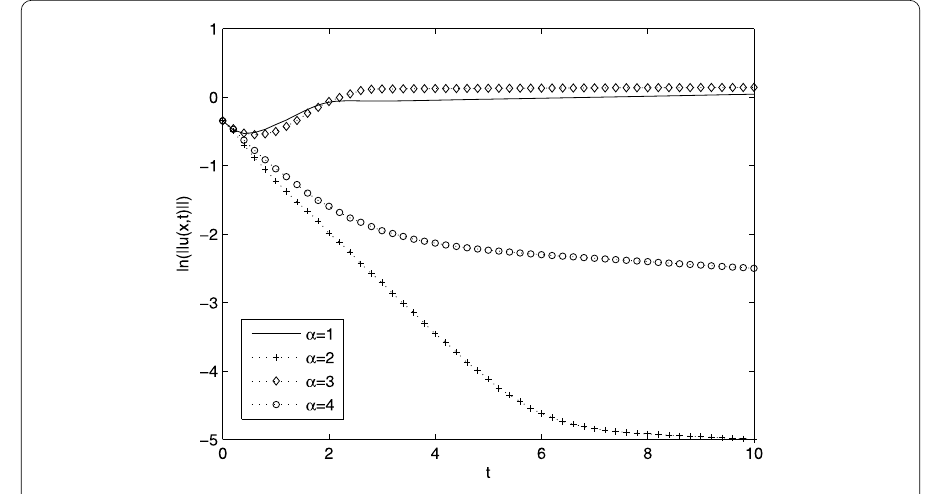
Figure 18 The natural logarithm of the L 2 -norm of u ( x , t ), ln( (cid:7) u ( x , t ) (cid:7) ), versus time for various values of α